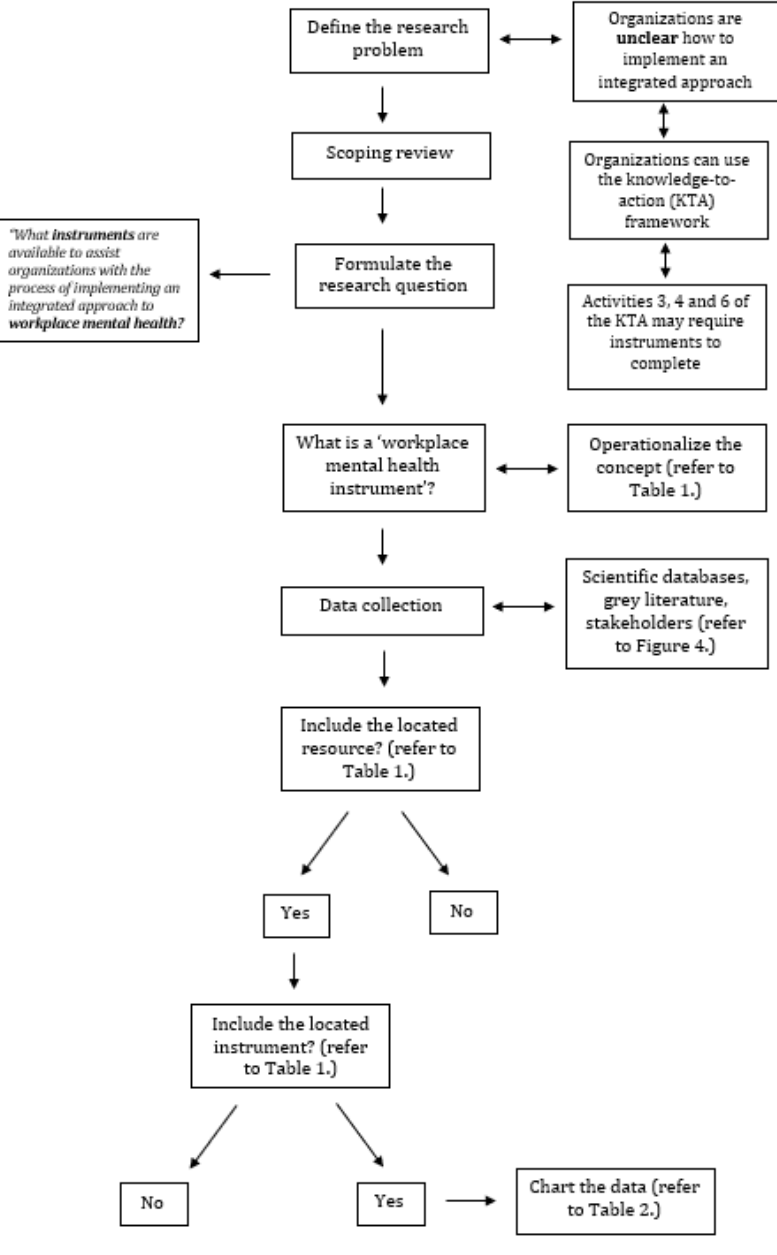
Figure 3. Methods flowchart.